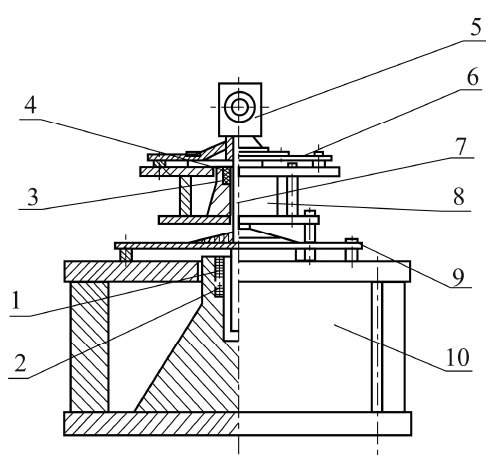
Figure 5. Mechanical vibration generator: 1, 3—generator windings; 2, 4—control winding;